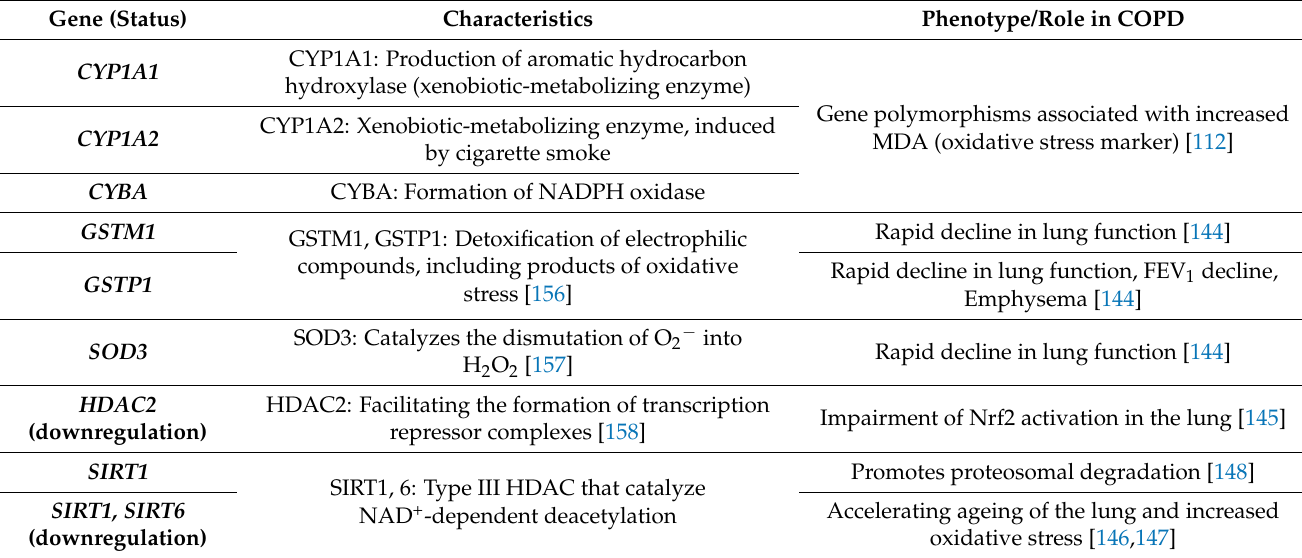
Table 2. Oxidative stress and genetic